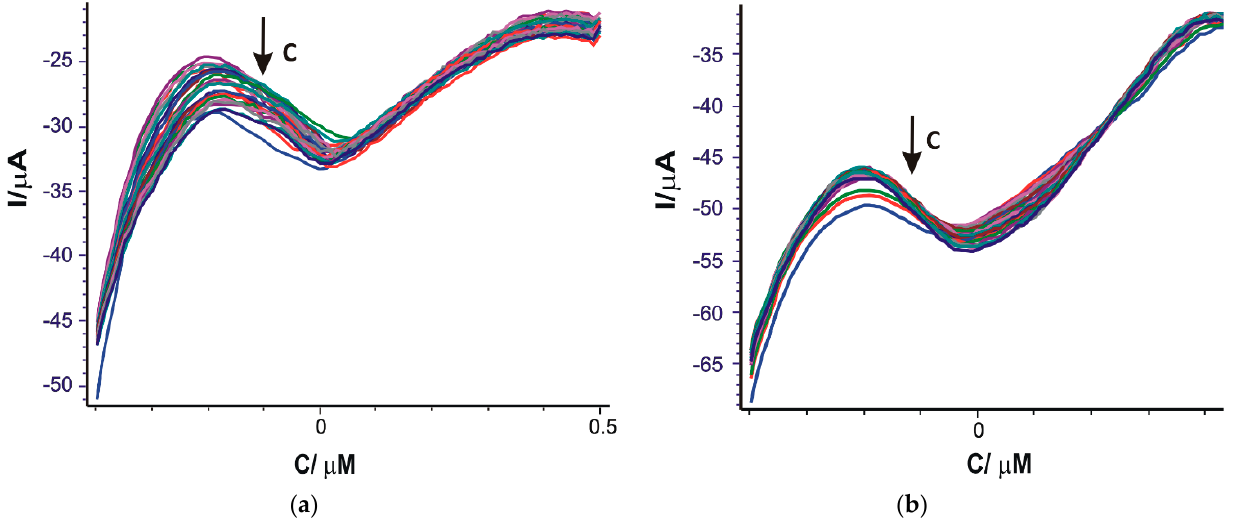
Figure 7. Square wave voltammograms recorded for SPE/SWCNT/Lac ( a ) and SPE/SWCNT/Tyr ( b ) on the concentration range 0.01–28.62 μ M OLEU. Different colors correspond to different concen- tration of the analysed solutions.